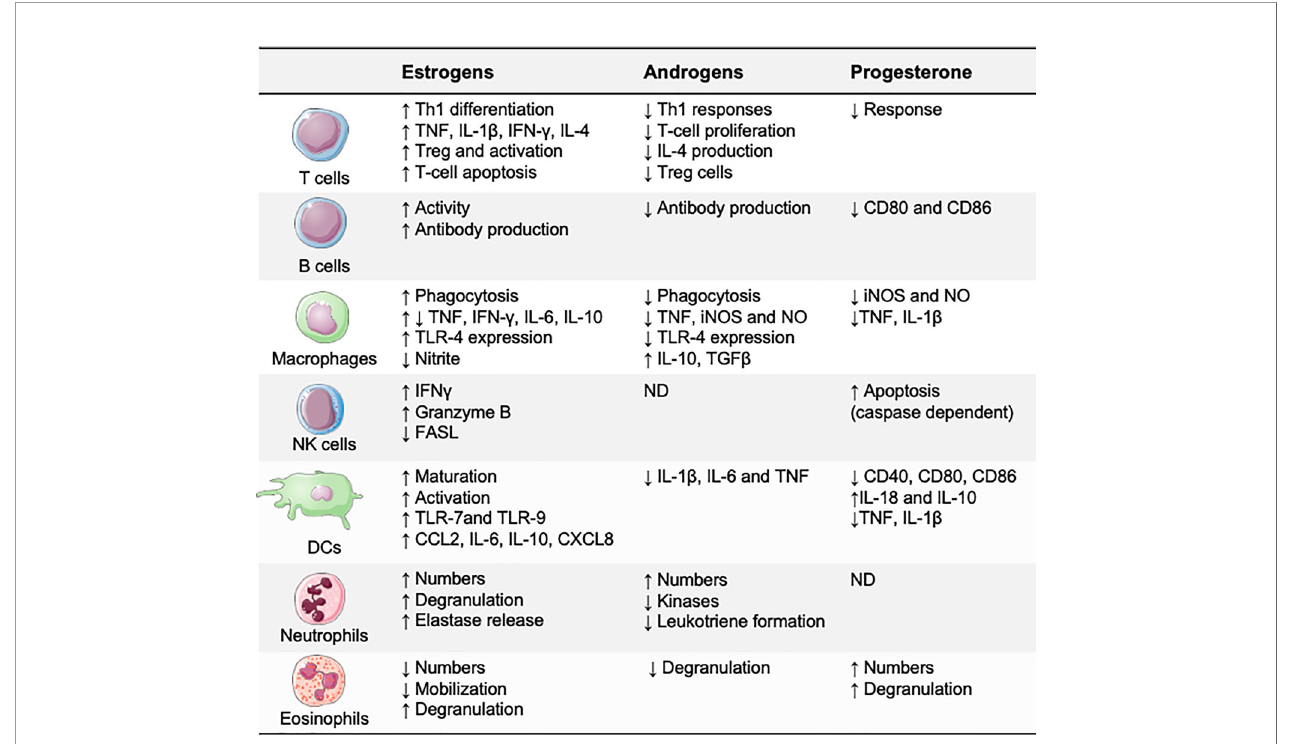
FIGURE 2 | Effects of sex hormones on the immune system. Estrogens, progesterone, and androgens may directly affect immune cell functions. Generally, testosterone and progesterone are anti-in fl ammatory, suppressing several of the immune responses necessary for in fl ammation, whereas estradiol has bipotential effects: proin fl ammatory at low concentrations and anti-in fl ammatory at high concentrations. CCL, CC − chemokine ligand; CXCL, CXC-chemokine ligand; FASL, FAS ligand; iNOS, inducible nitric oxide synthase; ND, not de fi ned; NO, nitric oxide; Treg, regulatory